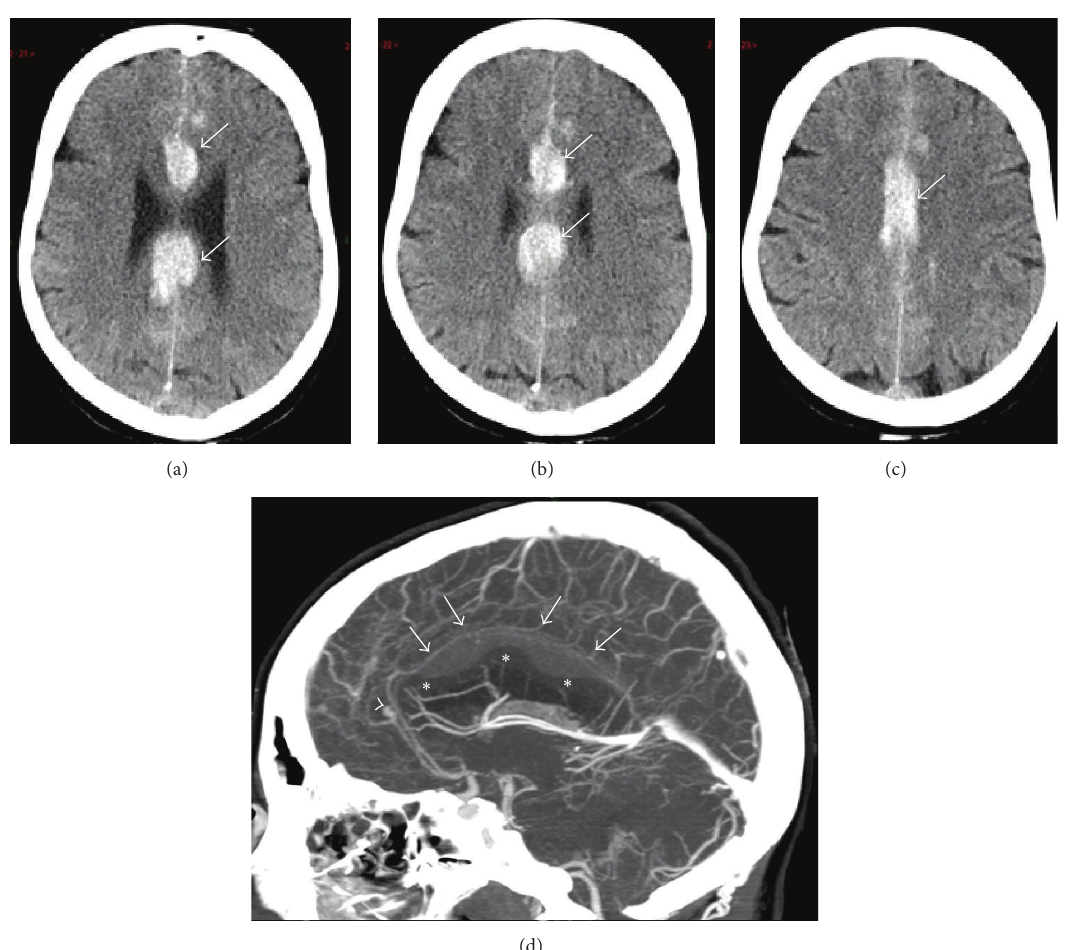
Figure 1: Admission brain CT scanner work-up of patient 1. (a–c) Serial unenhanced axial transverse views through the level of the corpus callosum showing massive hyperintense subpial hematoma at the cranial border of the corpus together (white arrows) with a mild SAH at the lateral borders of the frontal and parietal lobes, mainly on the left side. (d) Contrast-enhanced mid-sagittal reformatted Maximum Intensity Proton (MIP) view showing severe polylobulated impingement of the subpial hematoma (white arrows) on the corpus callosum (asterisks) and the causative microaneurysm on the left ACA (arrowhead). Note artifactual lowering of the apparent density of the hematoma because of changes in image scaling (window/level) after contrast agent